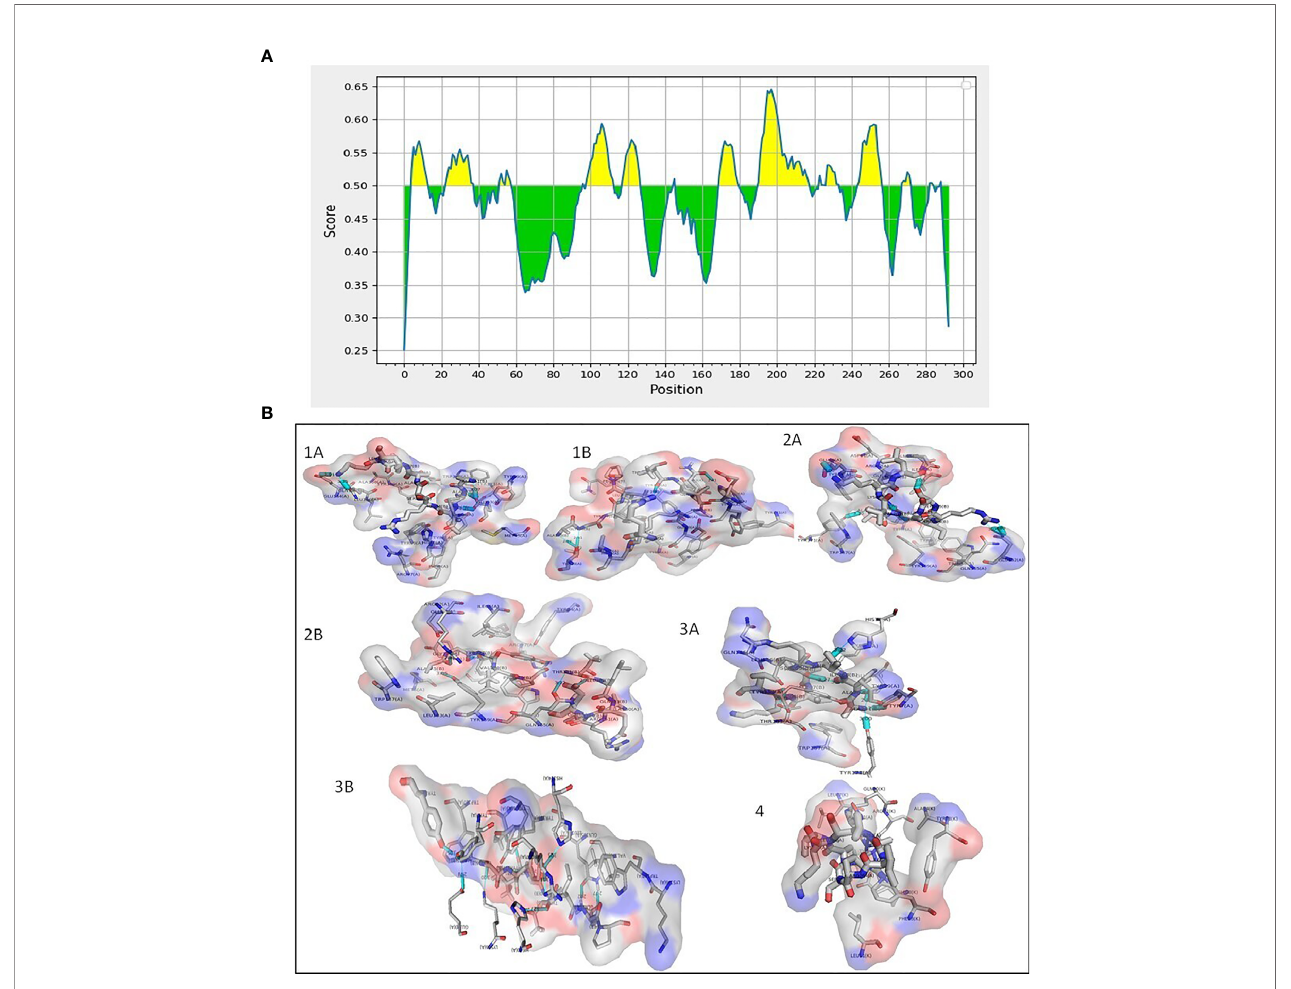
FIGURE 2 | (A) Predicted B cell epitopes of Rv1509 protein (yellow color). B cell epitopes present in Rv1509 were predicted using IEDB web-based tools. Protein sequence corresponding to Rv1509 as obtained from Mycobrowser was analyzed by Bepipred Linear Epitope Prediction 2.0. The Y-axes depicts for each residue the correspondent score while the X-axes depicts the residue positions in the sequence. The larger score for the residues is interpreted as a higher probability to be part of epitope (yellow color on the graphs). (B) Interaction study of Rv1509 epitopes with MHC I and MHC II (Cyan blue-Hydrogen bonding). (1A) HLA*A0201 allele interactions with AAIRSAVKL (T cell MHCI & II) epitope. (1B) HLA*A0201 allele interactions with AGYVPATLQP (B cell and MHCI) epitope. (2A) HLA*B1501 allele interactions with AAIRSAVKL (T cell and MHCI & II) epitope. (2B) HLA*B1501 allele interactions with AGYVPATLQP (B cell and MHCI) epitope. (3A) HLA*A0206 allele interactions with AAIRSAVKL (T cell and MHCI & II) epitope. (3B) HLA*A0206 allele interactions with AAIRSAVKL (B cell and MHCI) epitope. (4) HLA*DR1 allele interactions with AAIRSAVKL (MHCI and MHCII)